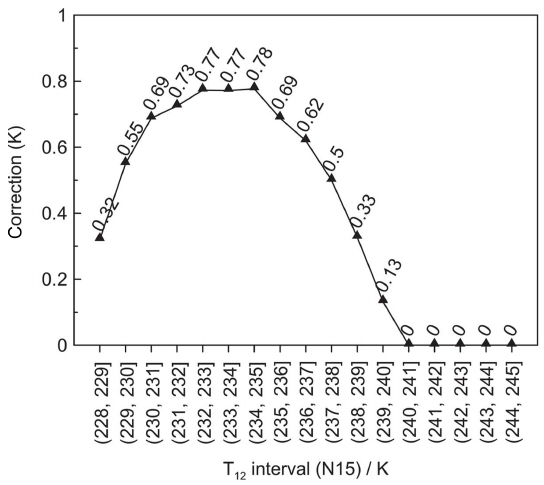
Figure 5. Corrections determined for 1K bins using the cdf-based procedure described in the text. Note that this procedure leaves all data exceeding 240K unchanged and that the necessary corrections at lower brightness temperatures are smaller than the regression- based corrections. The respective values are given in each interval for convenience for the potential user. Figure 6. As Fig. 2, but after correction of T